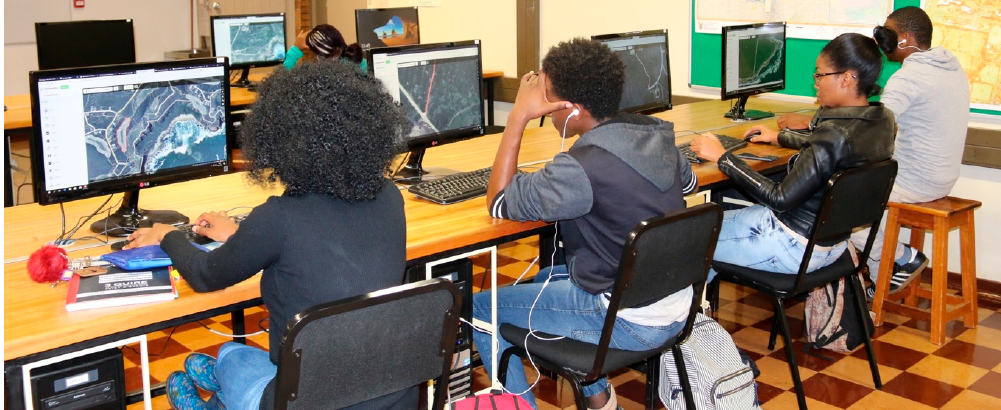
Figure 6. Students contributing OpenStreetMap (OSM) data during a mapathon.